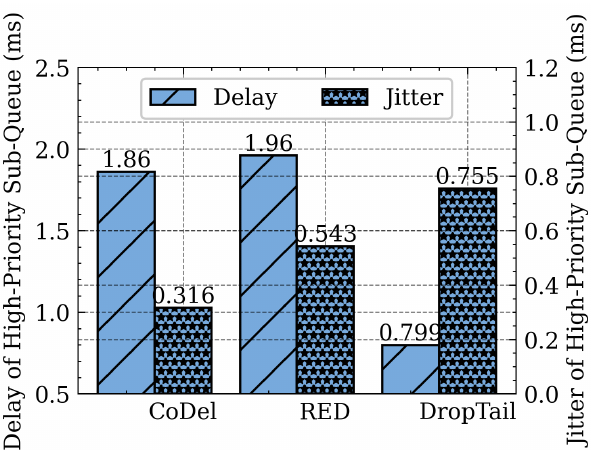
Figure 22. Different high-priority sub-queue management algorithm.